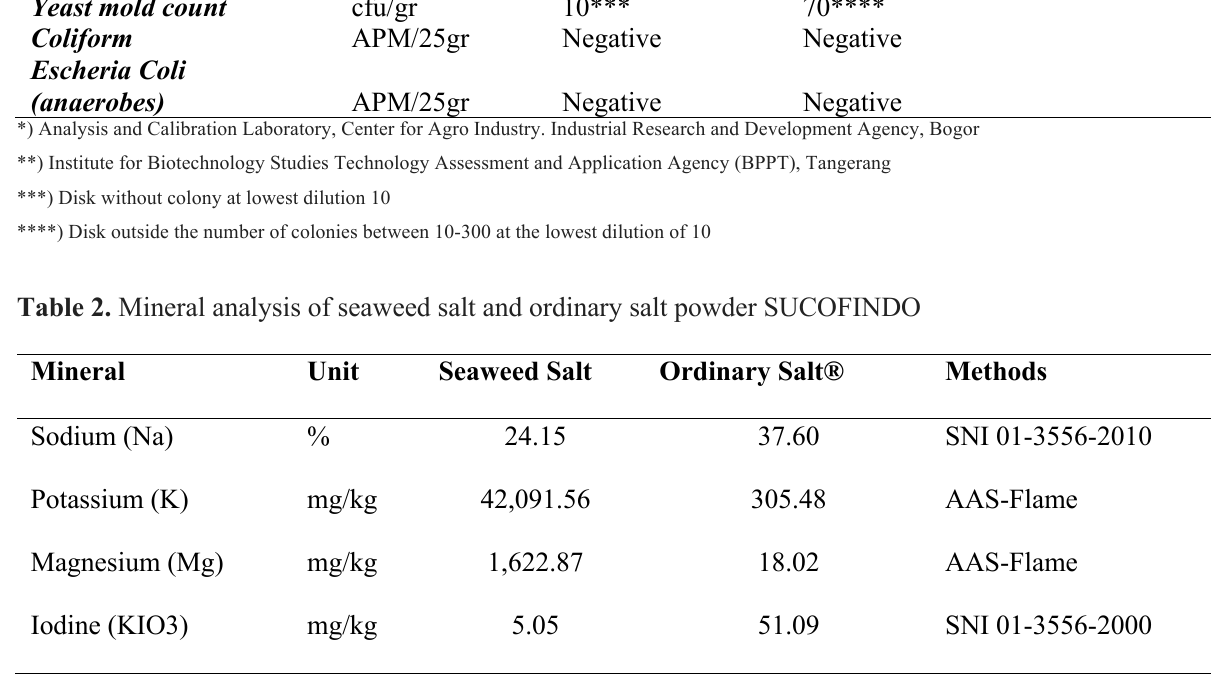
Table 3 . Salty sensory tests of seaweed salt and ordinary salt Variable